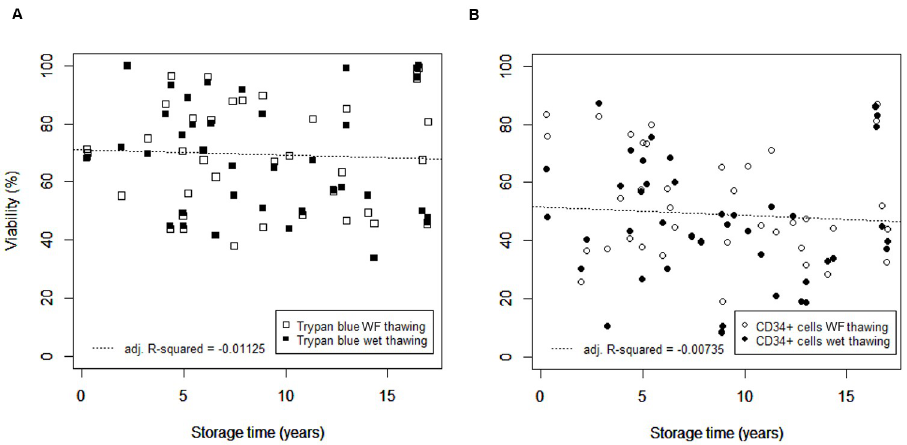
Fig 3. The comparative effect of cryogenic storage time of cryopreserved leukapheresis samples on the immediate post-thaw cell viability. (A) Immediate post-thaw cell viability determined as trypan blue exclusion or (B) by flow cytometry for CD34+ cells. Storage periods ranged between 3 months and 17 years, and results for water-free (WF) and wet thawing are presented as open and filled symbols, respectively. The linear model applied to the data as a function of cryogenic storage time is indicated by a dashed line. The adjusted square of the Pearson correlation coefficient (adj. R-squared) indicating the extent of variability in the dataset explained by the linear model, is provided.